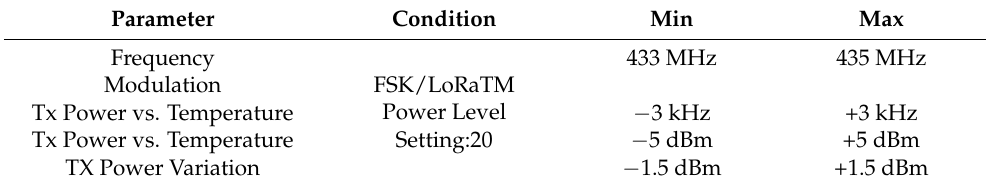
Table 4. Frequency and modulation hardware parameters of the LoRaWAN gateway used in an